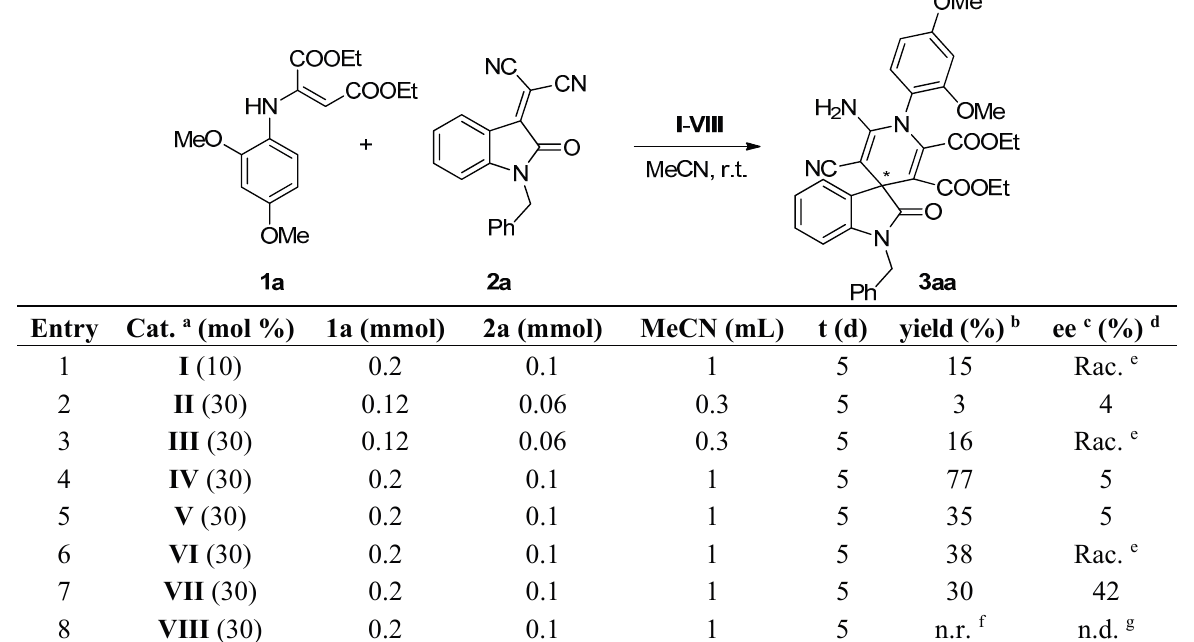
Table 1. Screening of catalysts I – VIII for the synthesis of chiral spirooxindole 3aa